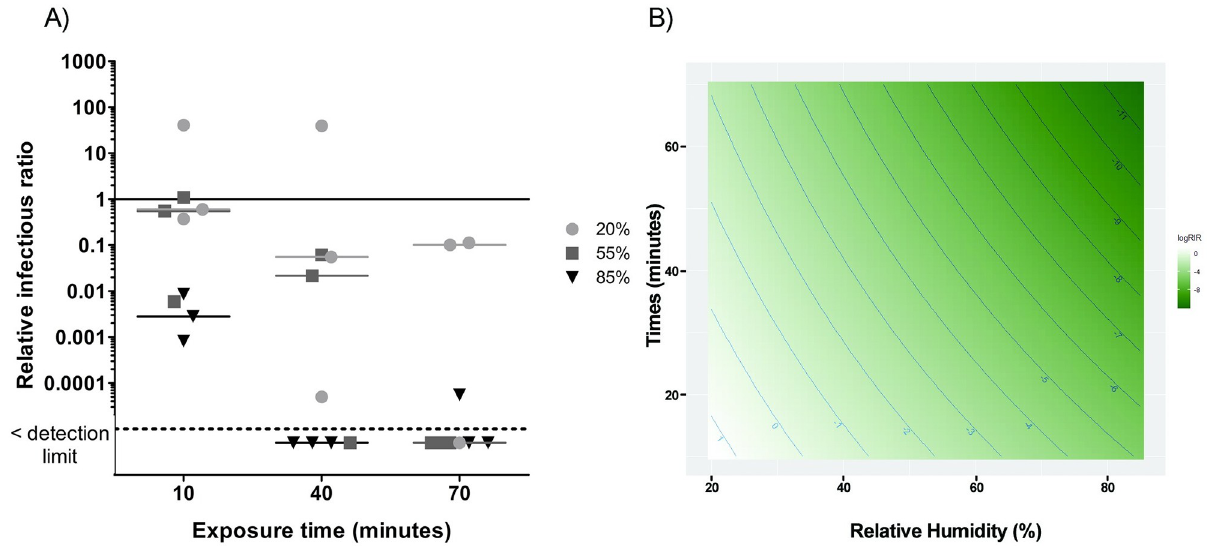
by triangles ( ▼ ). B) RSM between exposure time and humidity percentages for PR772. The darker the green colour, the greater the inactivation related to relative humidity and time